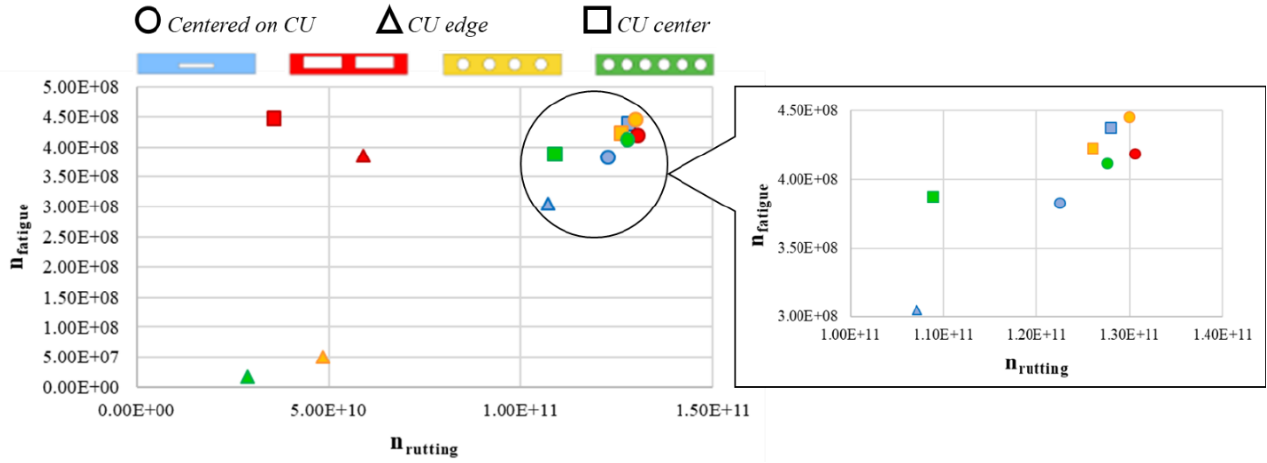
Figure 6. Comparison of the critical load cycles for fatigue and rutting phenomena, according to CU geometries and load positions.